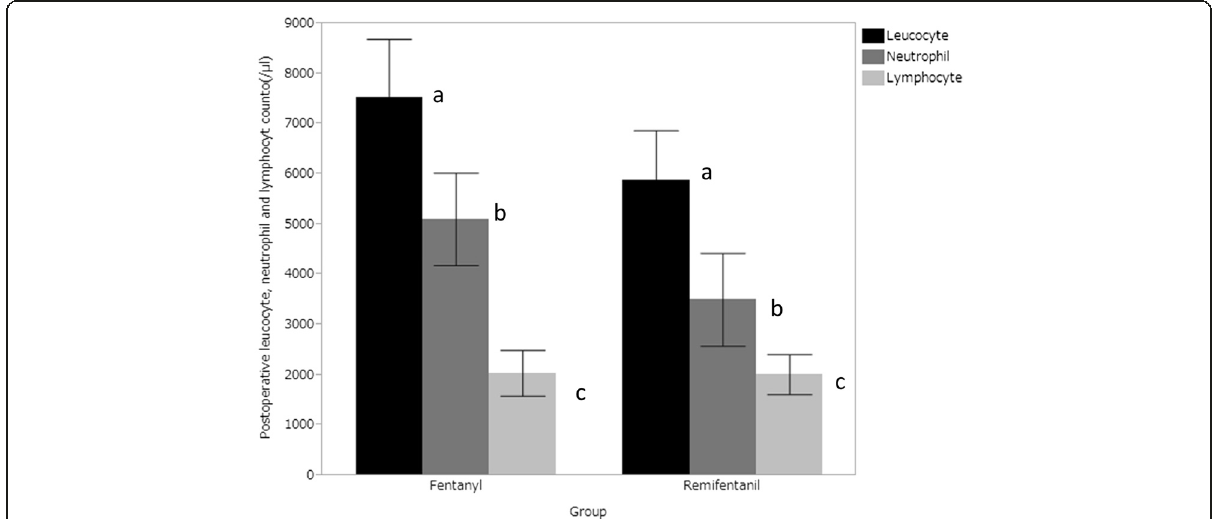
Fig. 1 Comparison of the postoperative numbers of leucocytes (black bar), neutrophils (gray bar) and lymphocytes (white bar) between the patients who received fentanyl-based anesthesia ( n = 20) and those who received remifentanil-based anesthesia ( n = 20). The leucocyte count (a: p = 0.03) and neutrophil count (b: p = 0.014) were significantly lower in patients who received remifentanil-based anesthesia than in those who received fentanyl-based anesthesia. Error bars represent the standard deviation. There was no significant difference in the number of lymphocytes between the two groups (c: p = 0.92)